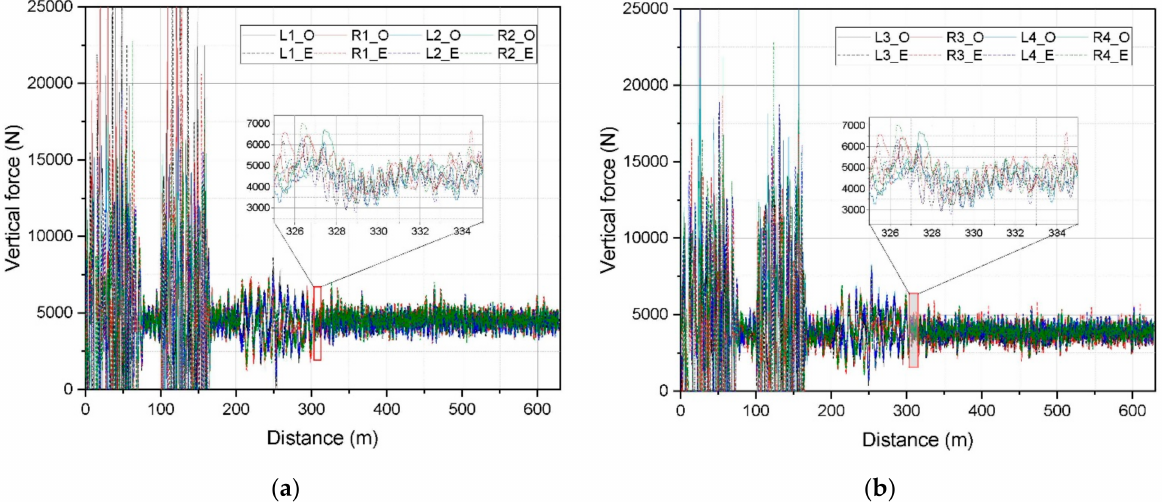
Figure 10. The comparison of vertical forces: ( a ) vertical forces for 1st and 2nd axles; ( b ) vertical forces for 3rd and 4th